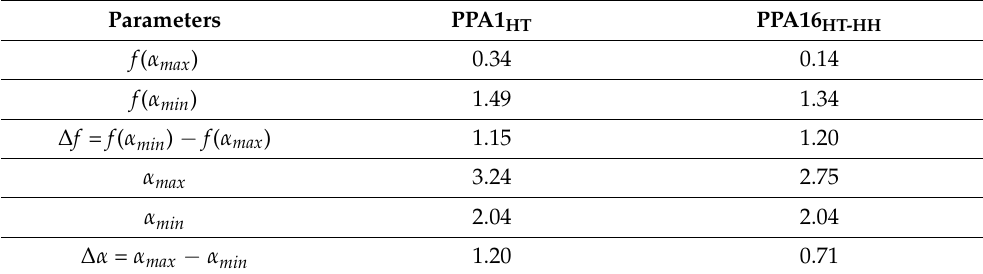
Table 2. Parameters of the multifractal